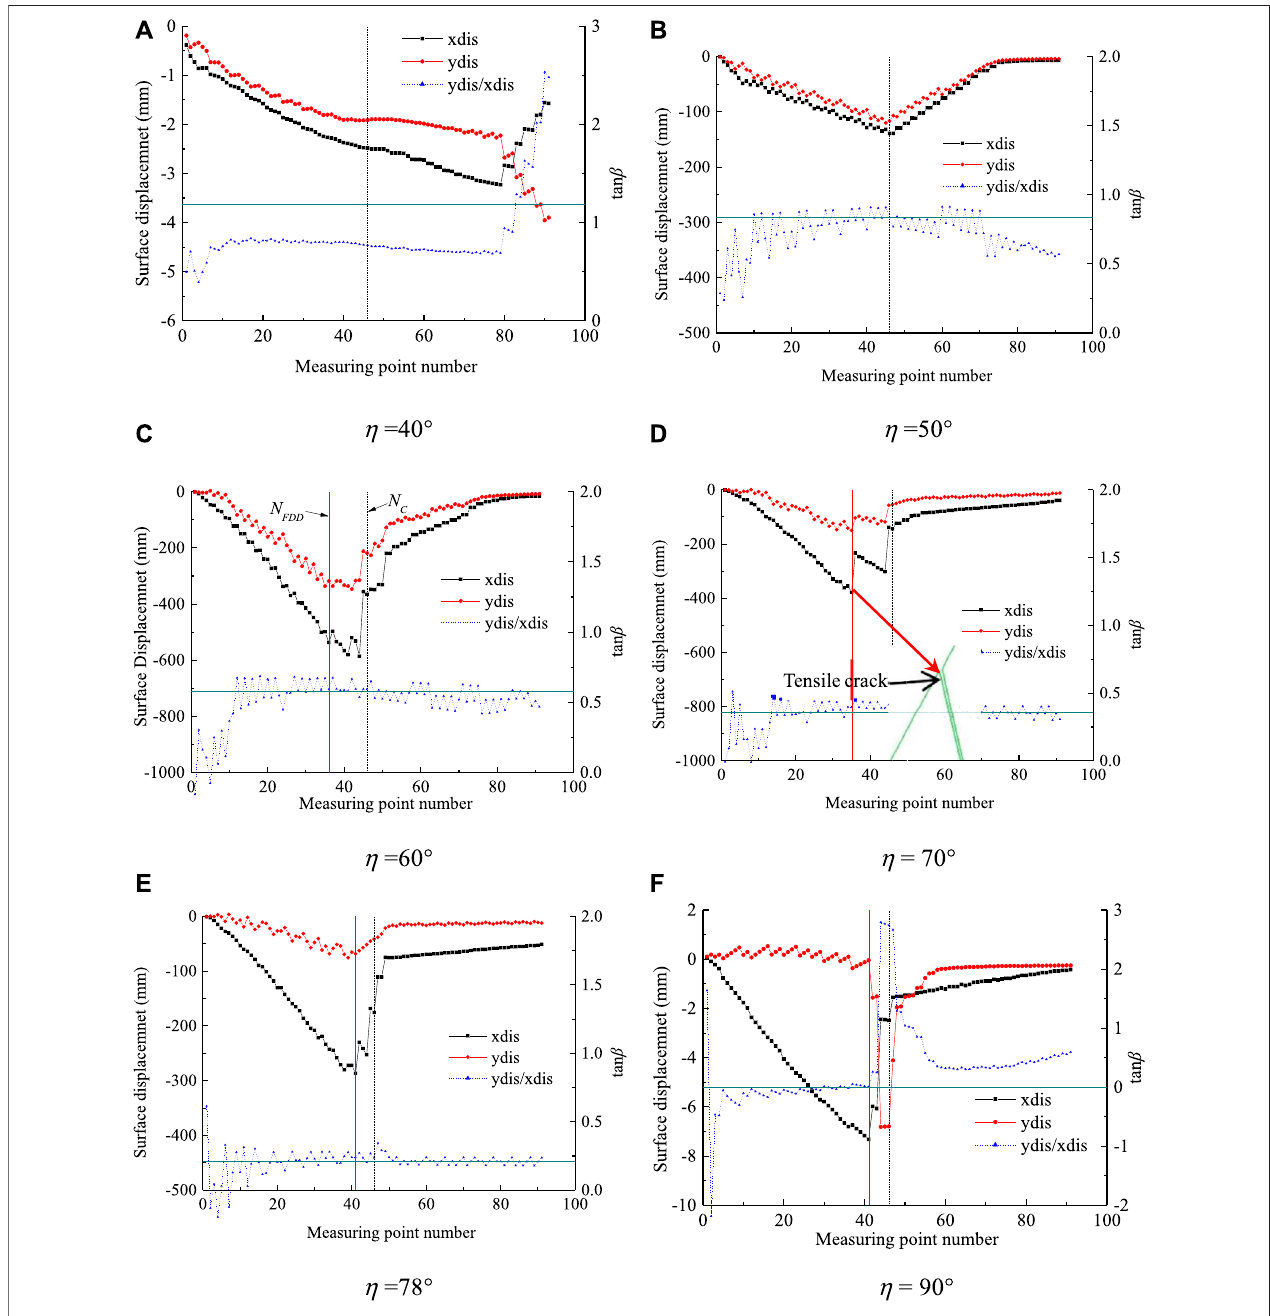
FIGURE 4 | Surface displacement distribution of slope for different joint angles ( η ). N C and N FDD : Measuring points corresponding to the slope crest and fi rst displacement discontinuity, respectively.